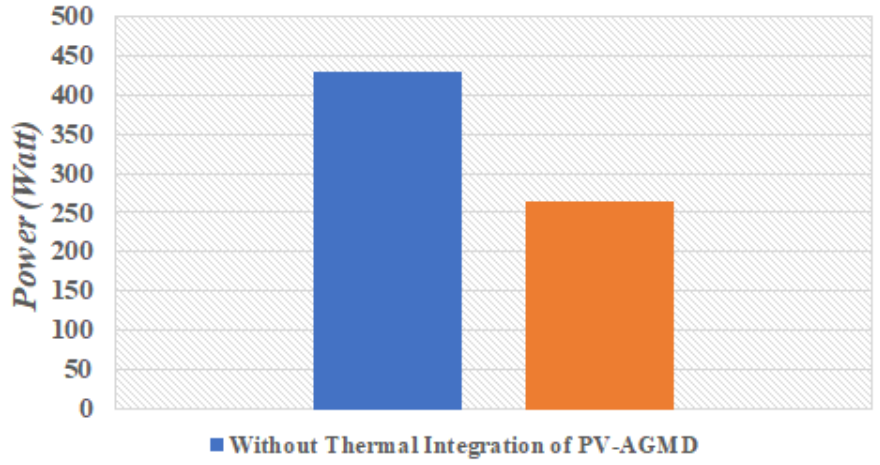
Figure 19. Energy consumption comparison.